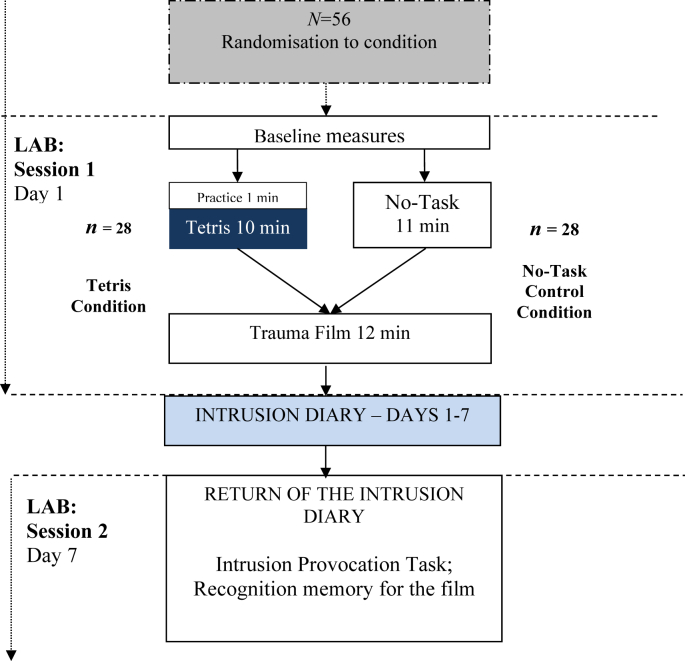
Procedural overview.